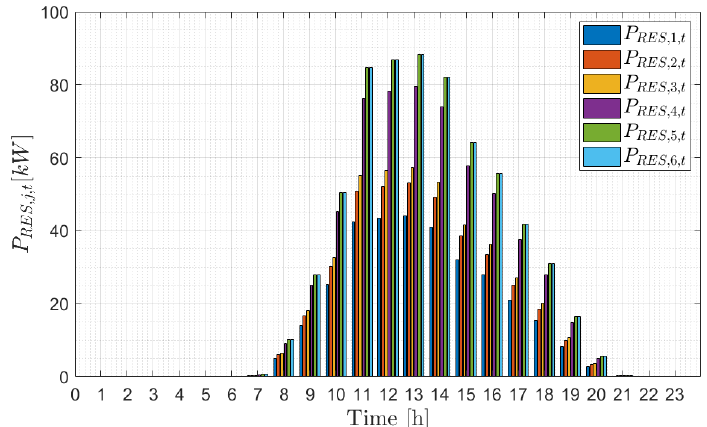
Figure 4. Renewable power production of the LUs.